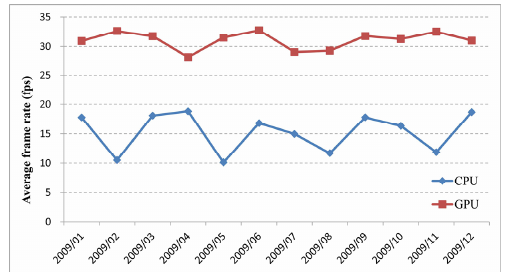
Figure 11. Performance comparisons of CPU and GPU-based spatiotemporal interpolations in rendering Figure 12 shows snapshots of different visualization results of air-sea SateCO 2 flux products. The original method projects and renders satellite data on the globe by a fixed colorbar from blue to red with the missing parts marked in black, as shown in Figure 12a. Figure 12b, 12c and 12d show three new rendering modes of flux particles, i.e., points, point sprites, and half-angle volume rendering. The rendering of point sprites is implemented by a geometry shader, and volume rendering is performed based on the results of point sprites.